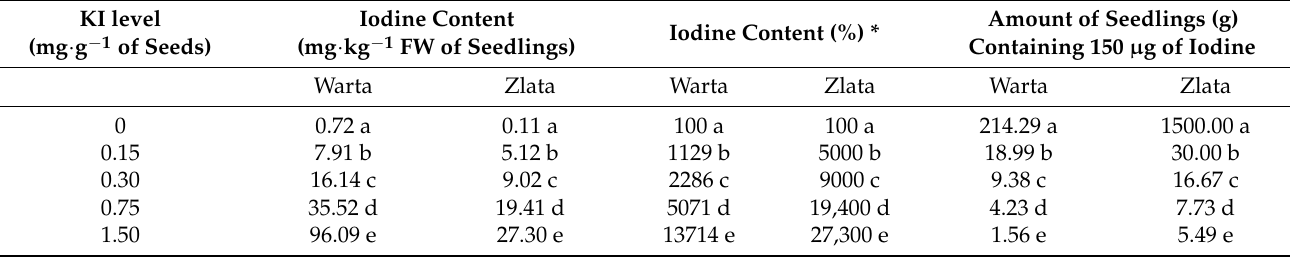
Table 1. Effect of level of KI application on the content of iodine in radish seedlings. KI level